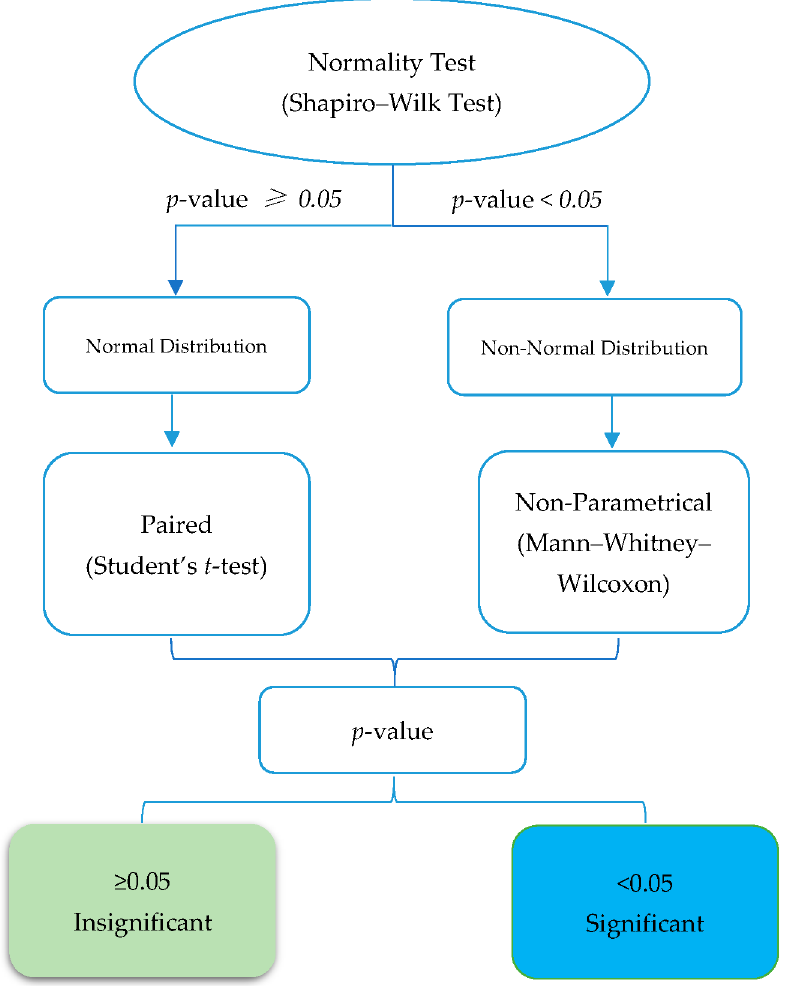
Figure 1. The flow of statistical analysis.